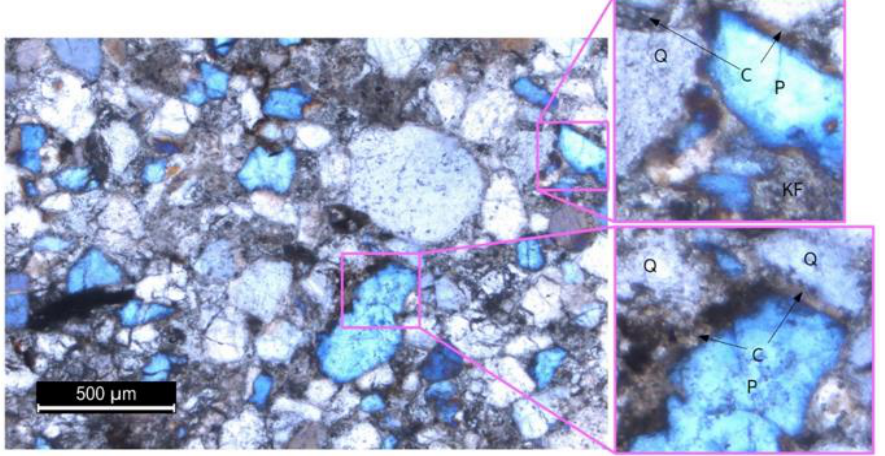
Figure 17. Textural and compositional features of L5-01. (Q) Quartz, (P) pore space, (C) chlorite grain coating, and (KF) kaolinite filling.